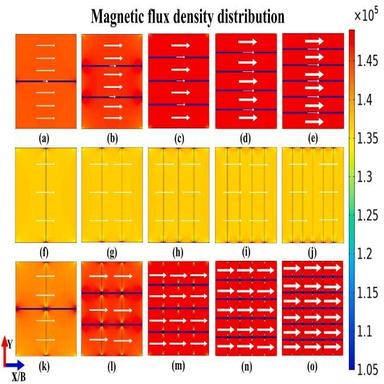
Magnetic flux density distribution of ferrite microstructures with different grain size and boundary orientations.